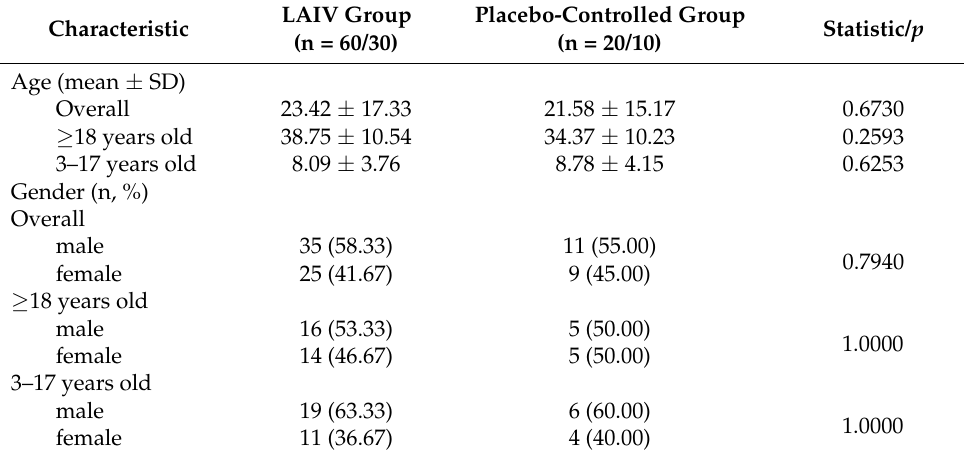
Table 1. Demographics characteristics of study participants.